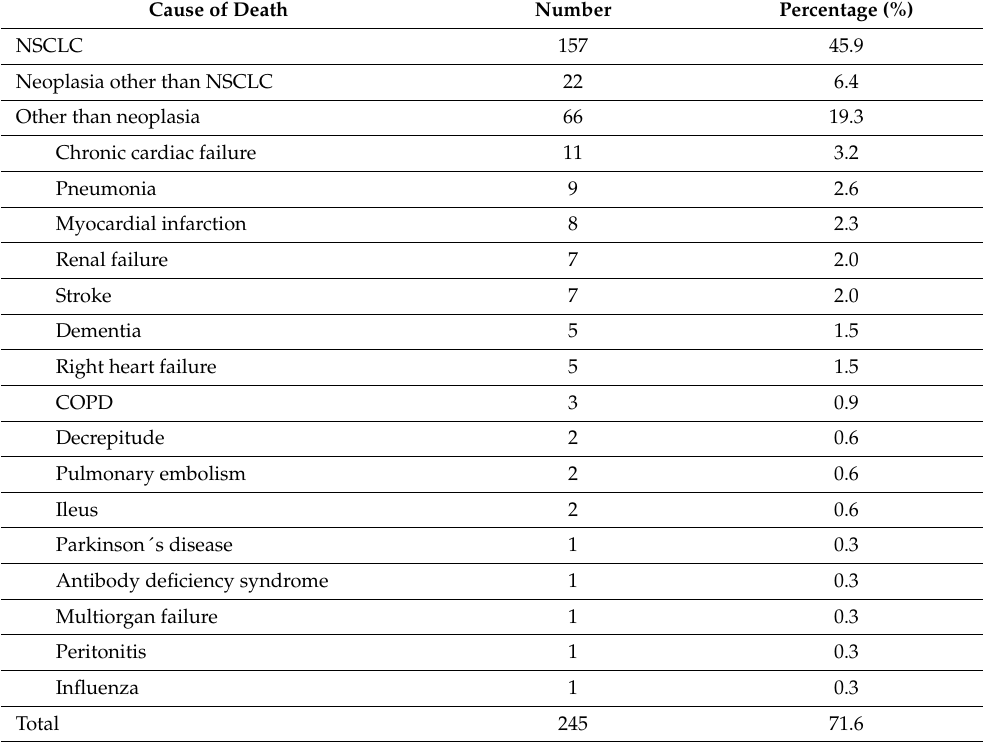
Table 3. Causes of death of 342 patients undergoing curative resection for NSCLC. Abbreviations: NSCLC: non-small cell lung cancer, COPD: Chronic obstructive pulmonary disease.